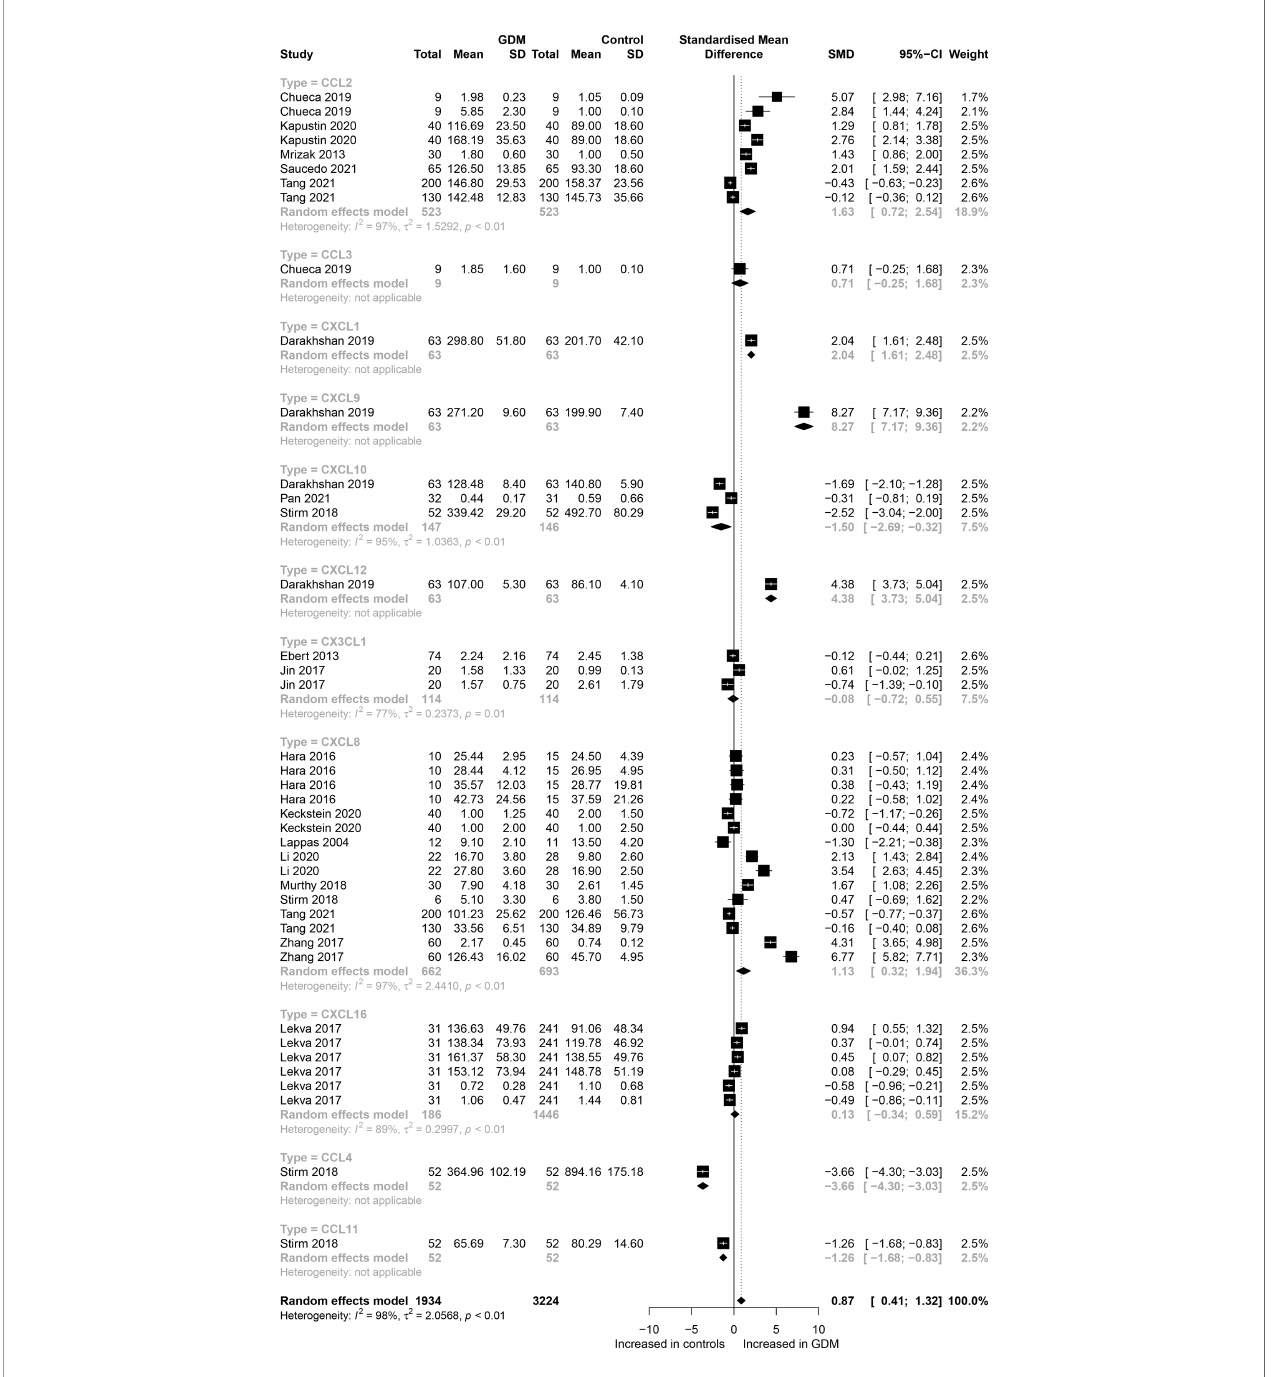
FIGURE 2 | Forest plot of chemokines between GDM patients and controls. Study effect sizes of chemokines differences between GDM and controls. Each data marker represents a study, and the size of the data marker is proportional to the total number of individuals in that study. The summary effect size for each chemokines is denoted by a diamond; GDM, Gestational diabetes mellitus; SMD, standardized mean